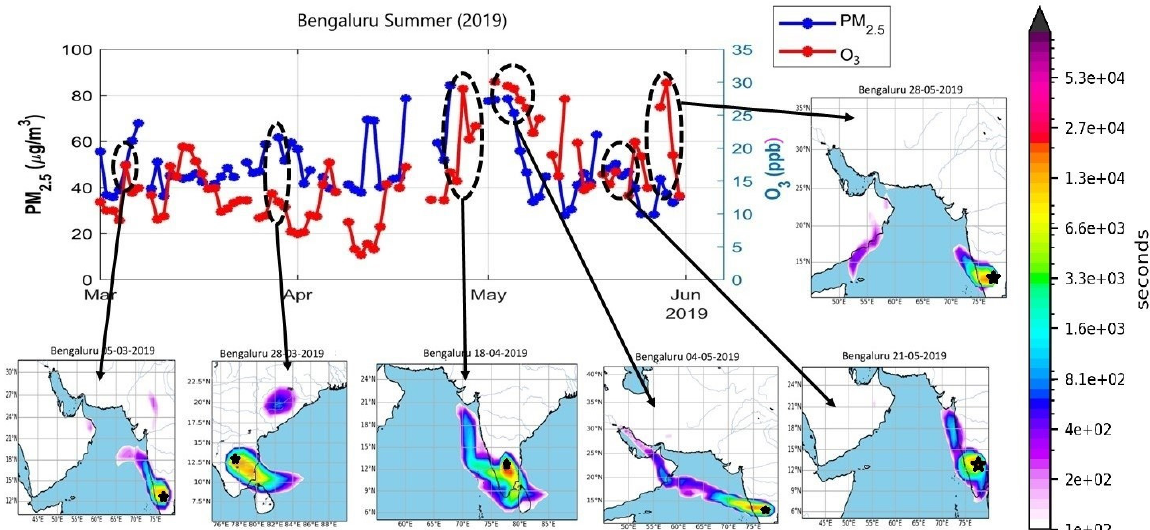
Figure 12. FLEXPART trajectory over Bengaluru for the summer season of 2019. Upper left panel shows simultaneous variations in PM 2.5 (blue) and O 3 (red). The FLEXPART images correspond to encircled points representing simultaneous enhancements in O 3 and PM 2.5 .